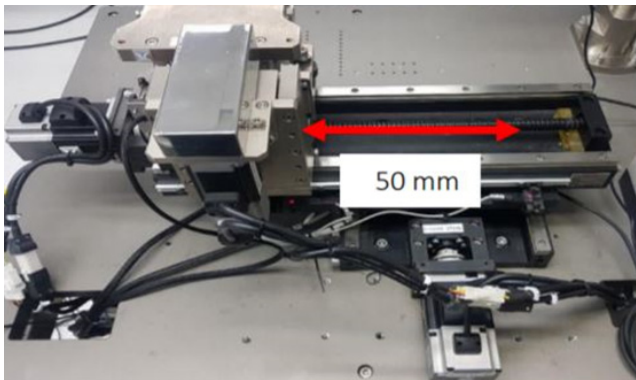
Figure 18. Worktable direction and position movement.